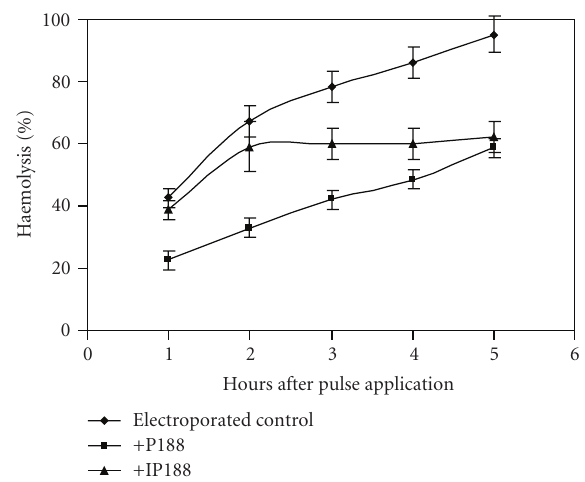
Figure 5: Altered haemolysis after the application of one rectan- gular pulse of 3kV · cm − 1 and duration 0.5 ms in the presence of 10 μ M poloxamer 188. +P188 indicates that erythrocytes were electroporated in the presence of 10 μ M P188, and + | P188 (10 μ M) indicates the addition of P188 after the electrical pulse.